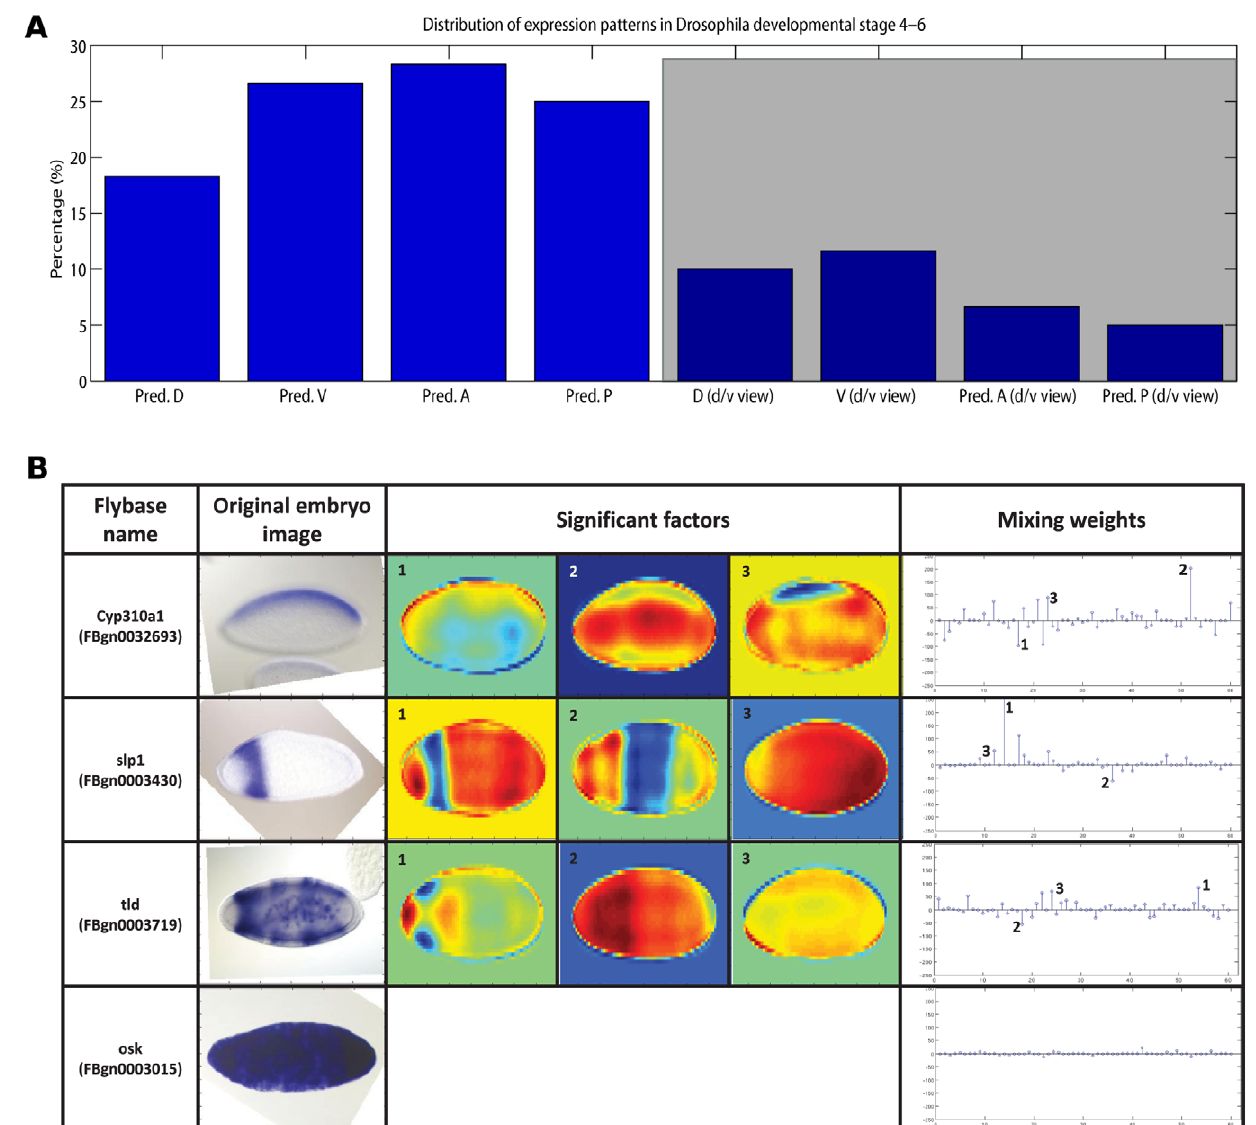
Figure 3. Distribution of expression patterns in Drosophila image data from stages 4–6. (A) Distribution of gene expression patterns. The height of the bars corresponds to the percentage of patterns in the indicated direction (lateral view for the first 4 bars and dorsal/ventral view for the remaining 4 bars, shaded area). Pred. D=predominantly dorsal (lateral view), Pred. V=predominantly ventral (lateral view), Pred. A=predominantly anterior (lateral view), Pred. P=predominantly posterior (lateral view), D (d/v view)=dorsal (dorsal/ventral view), V (d/v view)=ventral (dorsal/ventral view), Pred. A (d/v view)=predominantly anterior (dorsal/ventral view), Pred. P (d/v view)=predominantly posterior (dorsal/ventral view). (B) Example factor contributions. The top three rows show significant factors contributing to the original image decomposition, for lateral (anterior/posterior) and dorsal/ventral gene expressions. The bottom row corresponds to a non-informative (maternal expression only) case, where all factors share similar low weights for their image decomposition. Overall, for any given image (arbitrary orientation), factors which show that particular gene expression orientation are more likely to contribute to the image decomposition, through more informative weights.